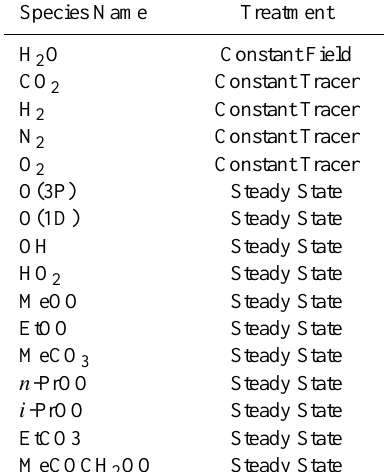
Table 3. Tracers/species in the UKCA standard tropospheric (StdTrop) scheme, where Me = CH 3 , Et = C 2 H 5 , Pr = C 3 H 7